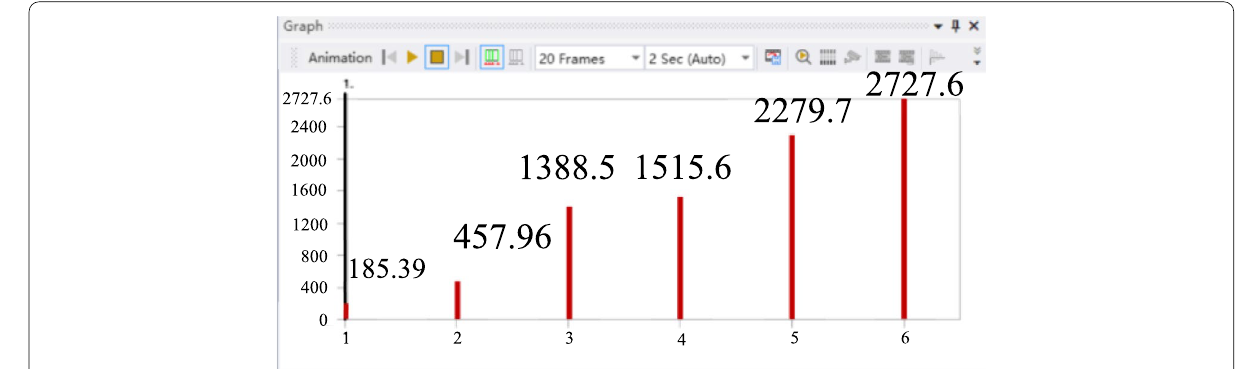
Fig. 10 Diagram of the first six natural frequencies of the micro-drive